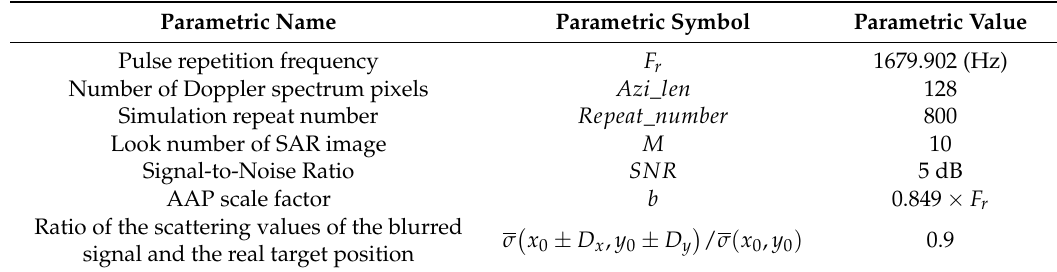
Table 1. Parameters of the simulated